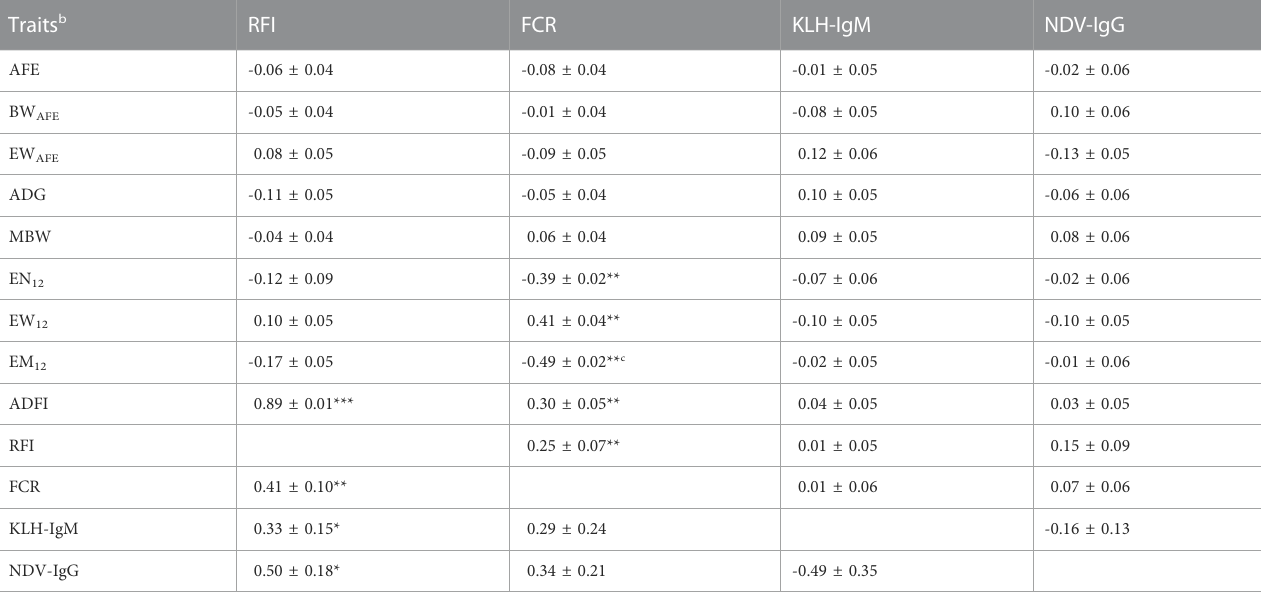
TABLE 5 Estimates of genetic a (lower diagonal) and phenotypic a (upper diagonal) correlations among production, ef fi ciency and immunity traits during the laying period (12 weeks from on-set of lay). Traits